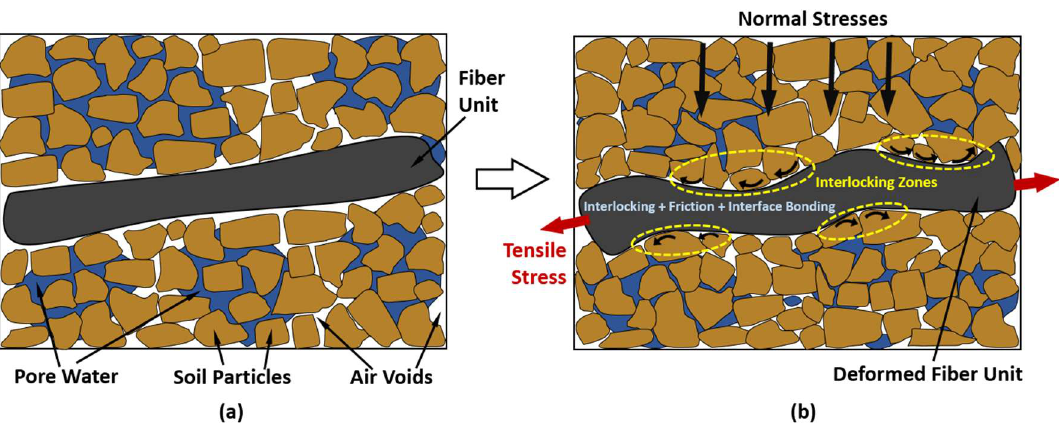
Figure 5. Schematic representation of a randomly distributed fiber unit at: ( a ) Initial stage ( b ) Deformation stage due to loading, where the effect of interlocking, friction and interface bonding induces mobilization of the tensile stress on the fiber unit.